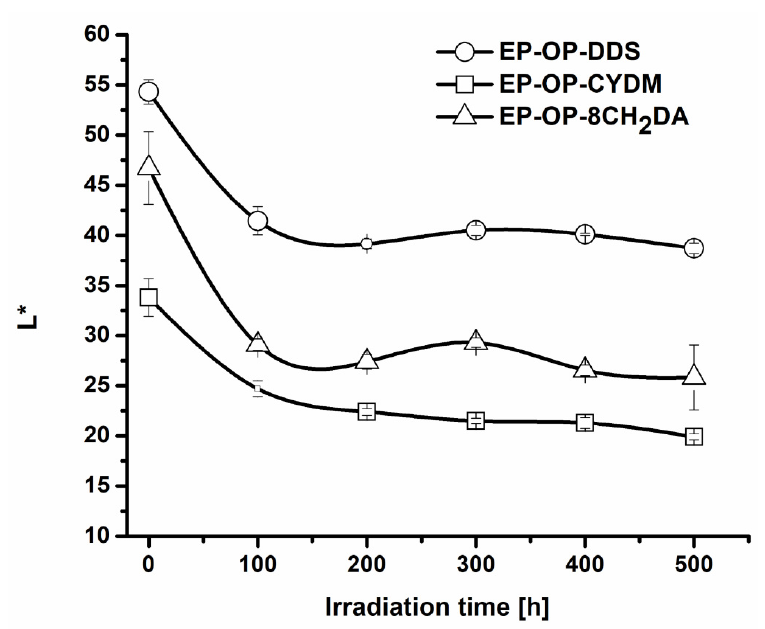
Figure 1. Variation of the L* parameter with irradiation time.